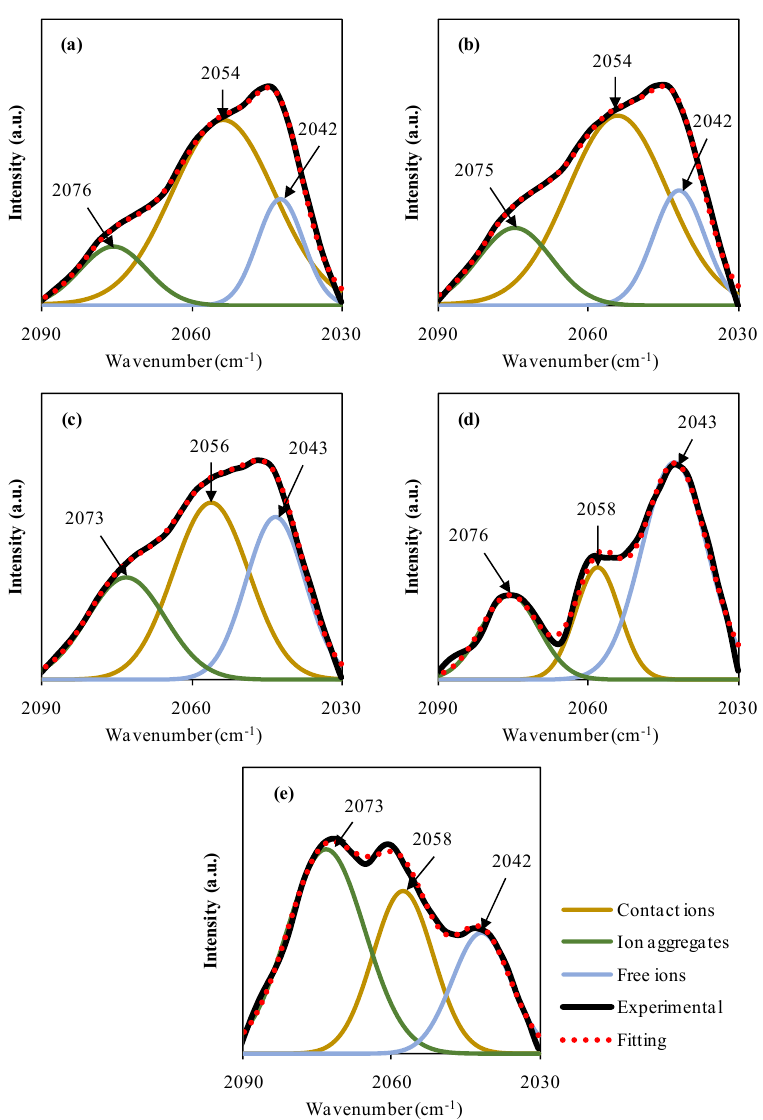
Figure 5. The SCN deconvoluted band for ( a ) MCK1, ( b ) MCK2, ( c ) MCK3, ( d ) MCK4 and ( e ) MCK5. According to the 𝜇 and D values in Table 3, the optimal quantity of salt for both transport parameters is 40 wt.% of salt. Free SCN-nucleophile anion possesses two highly reactive sites for N and S bonding, in addition to a bridge complex with the host polymer (SCN bending) [78,79]. When the polymers lose their structural order and intermolecular interaction, resulting in a more amorphous phase that facilitates better ion diffusion [80].